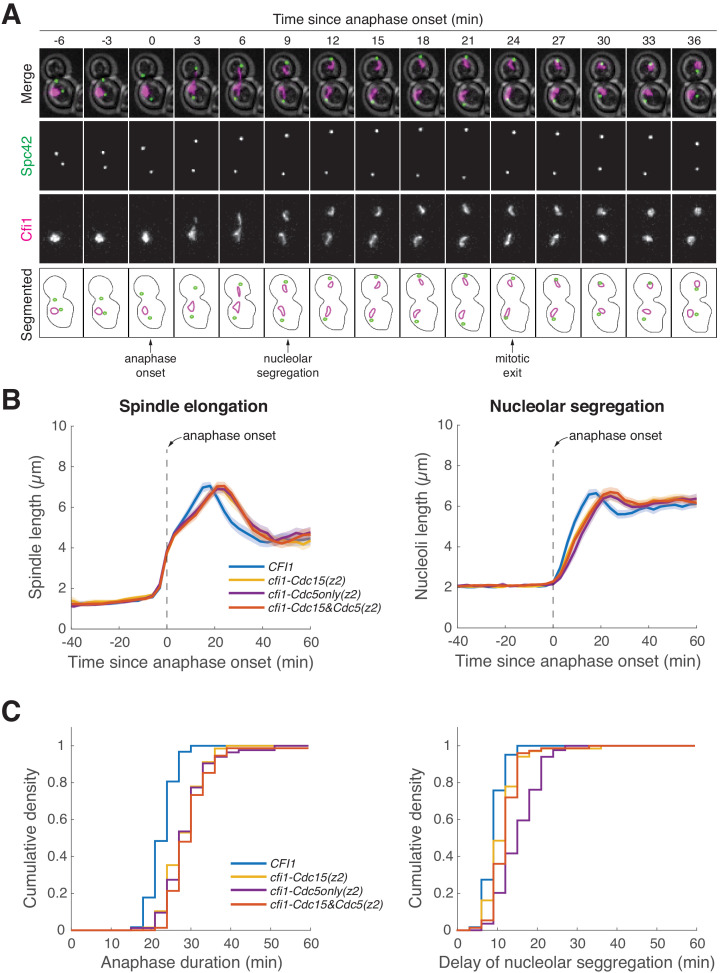
Cfi1/Net1 phospho-mutants delay mitotic exit and nucleolar segregation.(A) Tracking anaphase progression and nucleolar segregation using Spc42-eGFP and Cfi1/Net1-mScarlet-I as markers, respectively. A41436 cells were grown at 25°C in SC medium + 2% glucose and imaged every 3 min for 4 hr. (B) Quantification of spindle elongation (spindle length was estimated by measuring the distance between the two spindle pole bodies [SPBs]) and nucleolar segregation (nucleoli length was estimated by measuring the length of the major axis of the nucleolar mass) for CFI1/NET1 mutants using the SPB marker Spc42-eGFP and the nucleolar marker Cfi1/Net1-mScarlet-I (A41436, A41590, A41591, and A41592; same dataset as in Figure 6C). Single cell traces were aligned to anaphase onset (spindle length >3 μm) and averaged. Solid lines represent the average. Shaded areas represent 95% confidence intervals. (C) Cumulative density of anaphase duration (left) and delay of nucleolar segregation (right) for cells in (B). Anaphase duration was defined as the time from anaphase onset (spindle length >3 μm) to mitotic exit (spindle breakdown, determined as relaxation of the distance between SPBs). Delay of nucleolar segregation was defined as the time of nucleolar segregation (clear separation of two nucleolar masses) relative to anaphase onset.